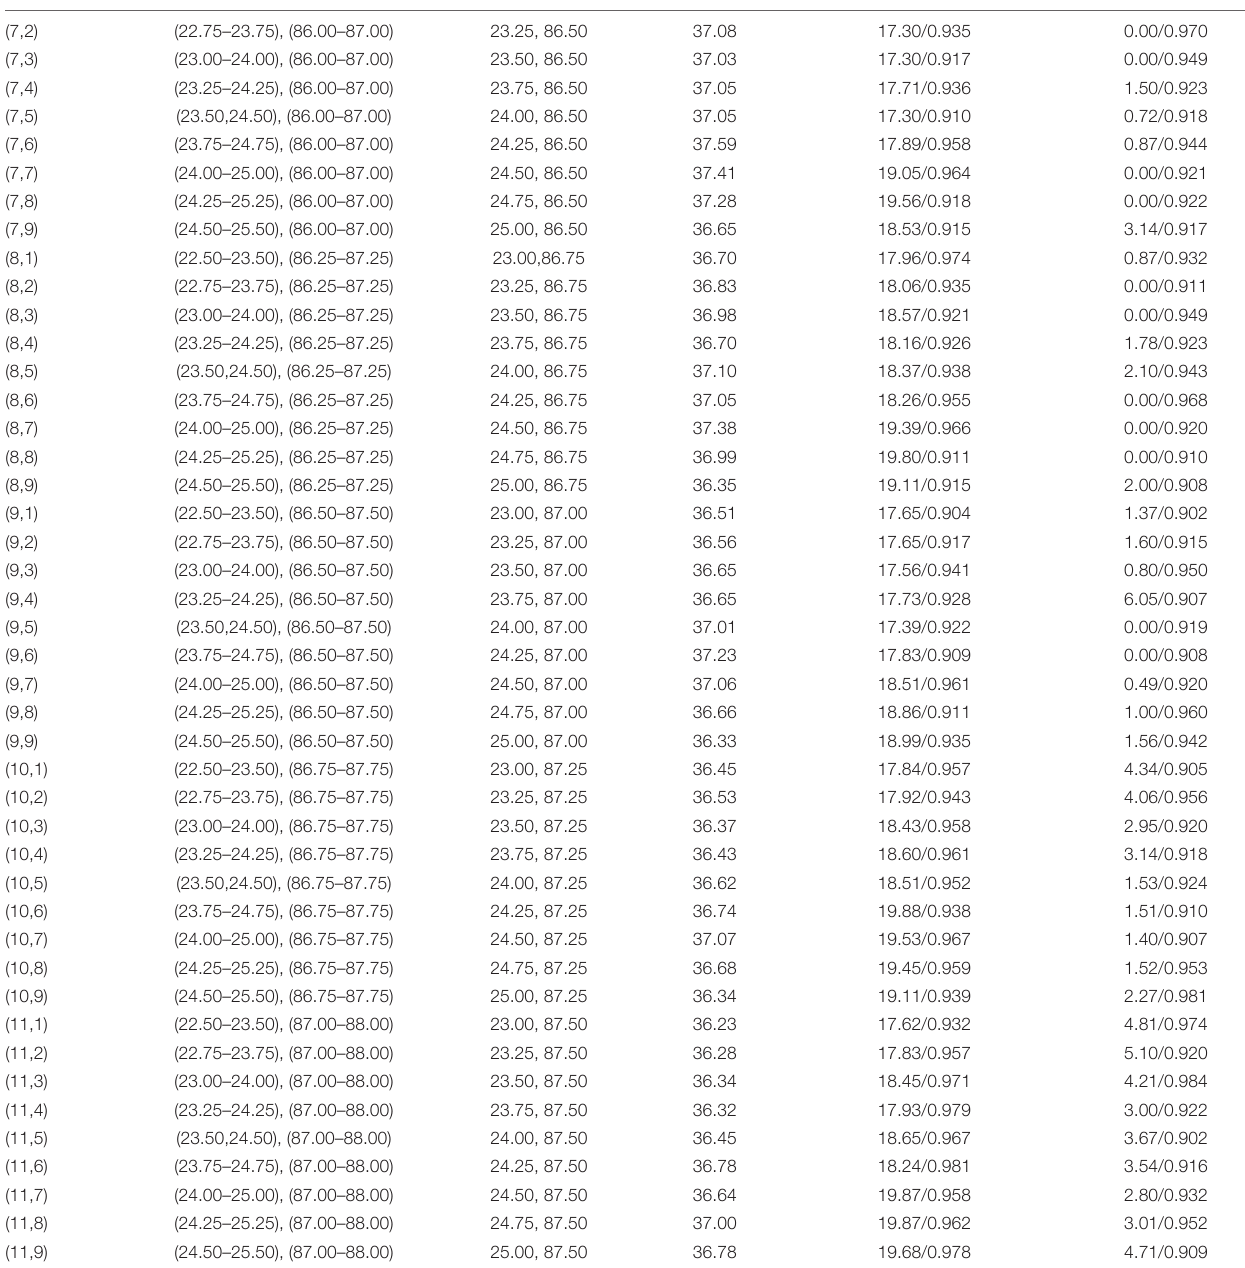
R 2 : coefficient of determination, i.e., fitness of the best fit line on spectrum.